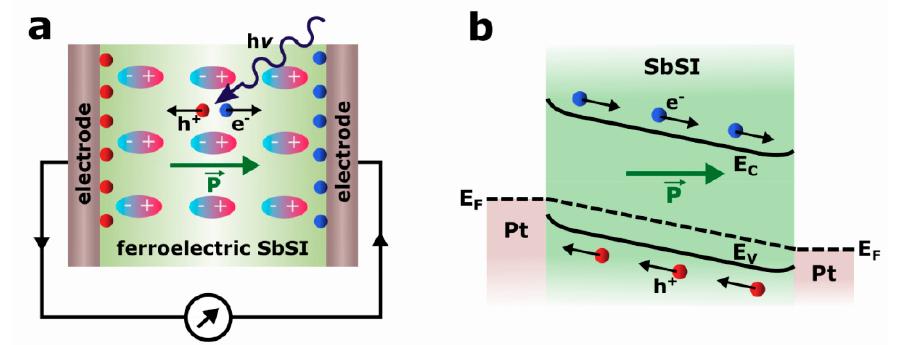
Figure 8. The mechanism of photocurrent generation ( a ) and energy band diagram ( b ) of a poled Pt/SbSI/Pt ferroelectric-photovoltaic device (e − —electron; h + —hole; P—electric polarization; h ν —photon; E F —Fermi level; E C —bottom of conduction energy band; E V —top of valence energy band).